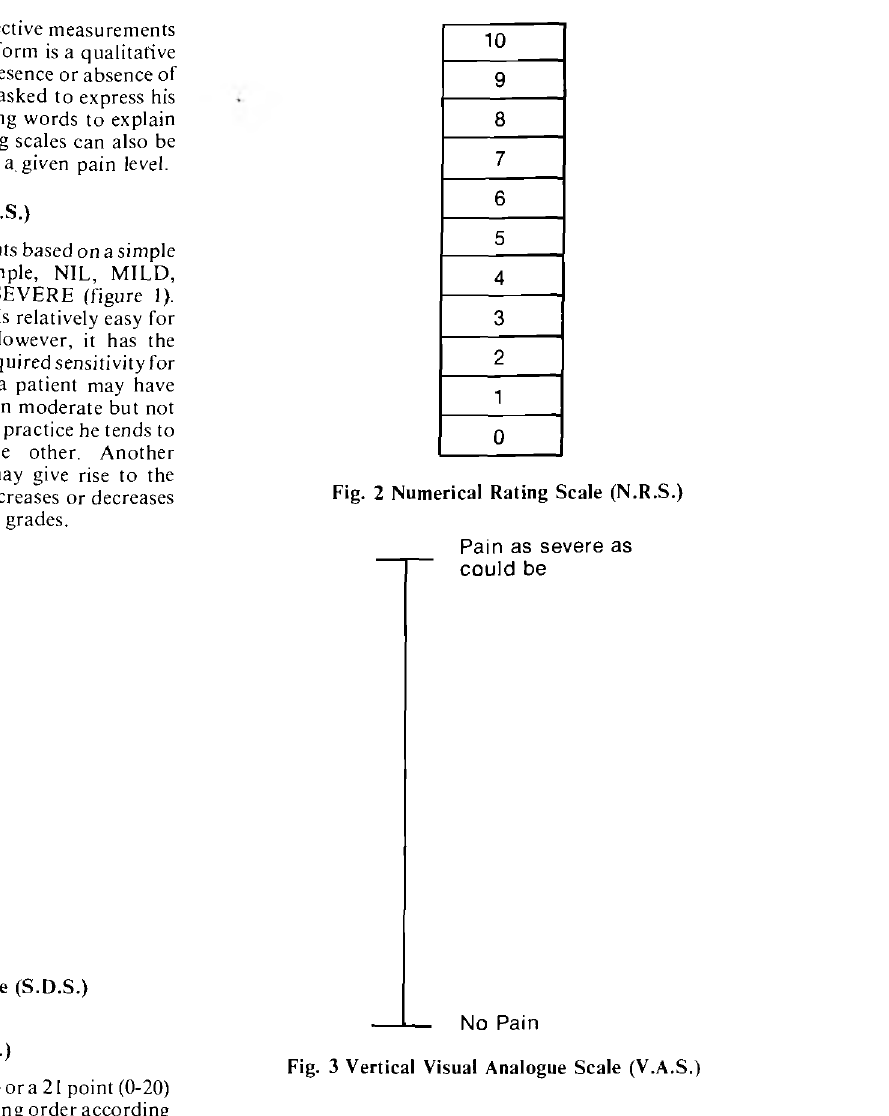
Fig. 3 Vertical Visual Analogue Scale